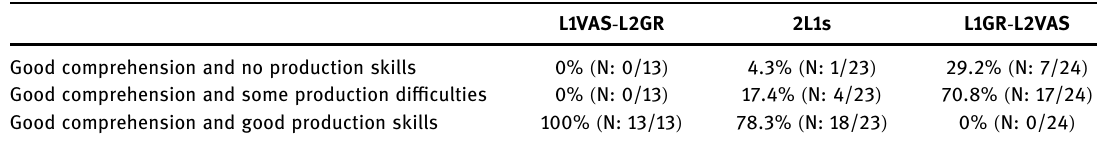
Table 4: Self - assessment of language skills in VAS